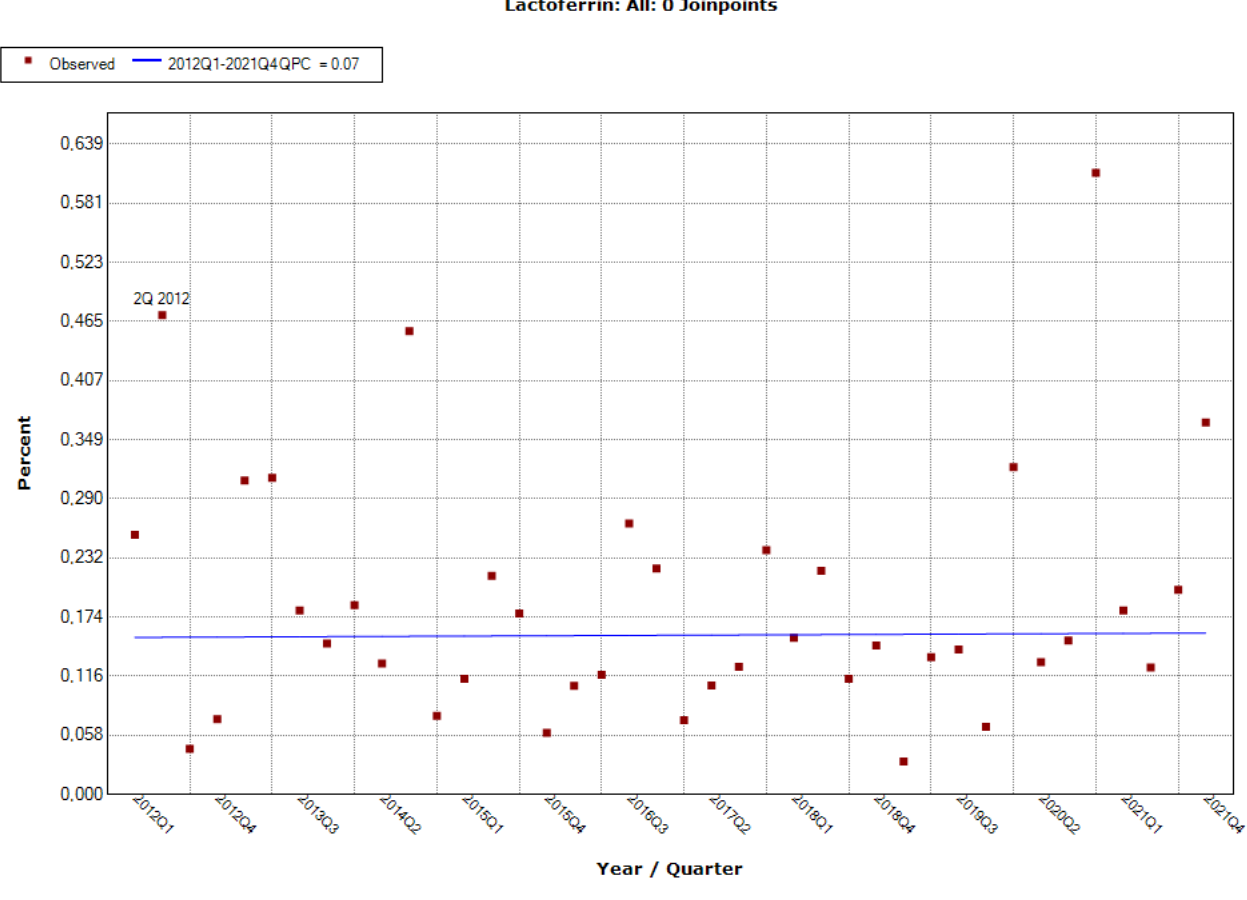
Figure A3. Percentage of products containing lactoferrin in individual quarters in the period from 2012 to 28 November 2021. Joinpoints mark trend turning points. The date above the observation indicates the moment of publication of the scientific opinion/resolution.